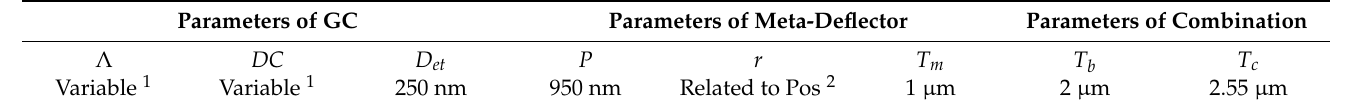
Table 1. Parameters of PVGC.